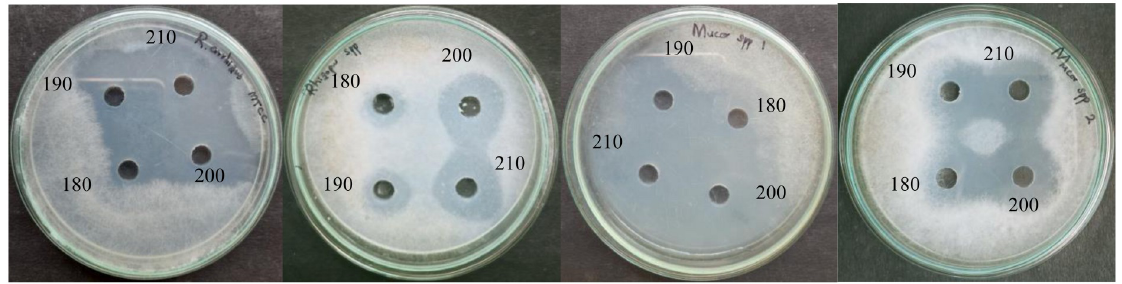
Fig 8. Evaluation of minimum inhibitory concentration of 3-phenyllactic acid against Rhizopus arrhizus MTCC 24794, Rhizopus sp., Mucor sp. 1, and Mucor sp.